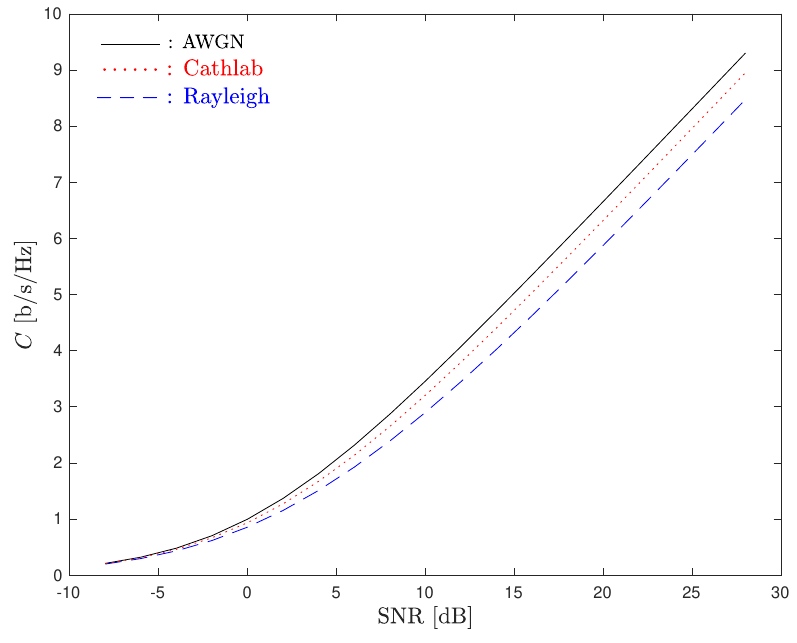
Figure 9. Ergodic system capacity considering different channels and a SISO-OFDM